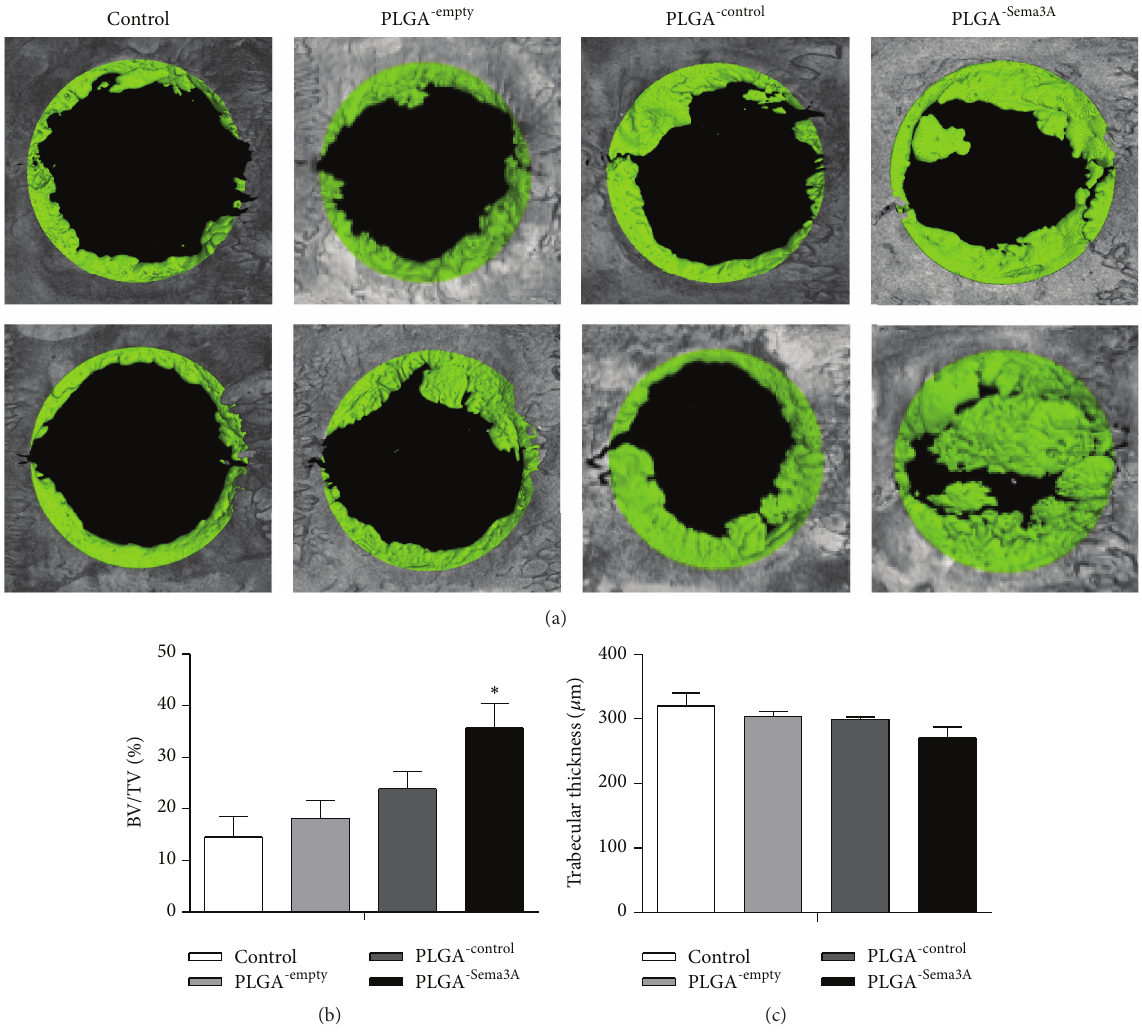
Figure 5: ASC - Sema 3 A engrafted PLGA scaffold increases bone repair in the calvarial defect model. (a) Representative images showing bone defect healing after 4 or 16 weeks of treatments. Control indicates that defects received nothing; PLGA - empty , PLGA - control , and PLGA - Sema 3 A indicate that defects implanted with ASC, ASC - control , and ASC - Sema 3 A , respectively. BV/TV (b) and trabecular thickness (c) of the regenerated bone 16 weeks after transplantation. Mean ± SD, 𝑛 = 5 , and ∗ 𝑝 < 0.05 . BV, bone volume; TV, total